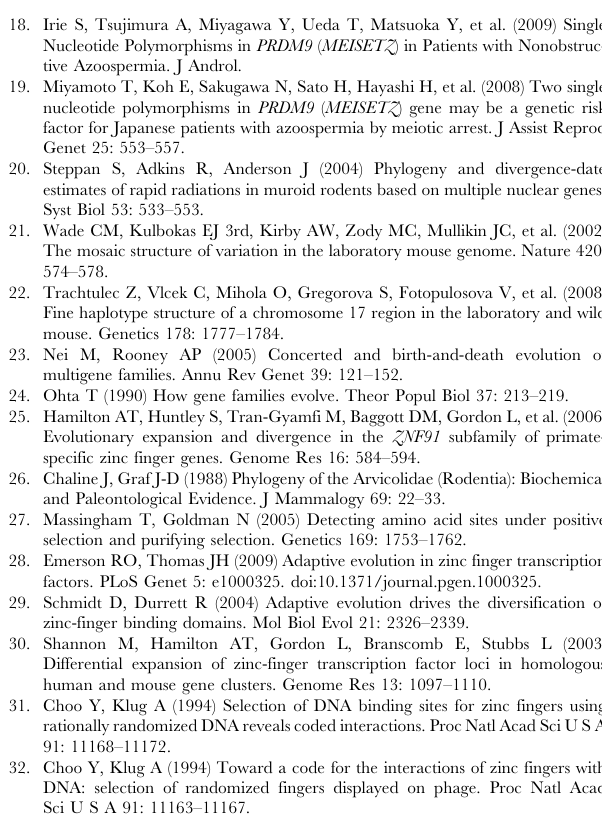
Figure S1 Phylogenetic tree of rodent Prdm9 zinc finger nucleotide sequences as inferred by phyml [76] version 3.0 (http://www.atgc-montpellier.fr/phyml/) and drawn using Fig- Tree (http://tree.bio.ed.ac.uk/software/figtree). Zinc fingers are numbered sequentially from the C-terminal array. The exceptions are zinc fingers from the mouse and rat, whose numbers start from the first Prdm9 zinc finger in exon 11. For species names see legend to Figure 6. Branches with Approximate Likelihood-Ratio Test values of over 0.75 are indicated with bold lines. Found at: doi:10.1371/journal.pgen.1000753.s001 (6.18 MB EPS) Figure S2 Multiple sequence alignment (shaded according to a 90% consensus) of Prdm9 zinc finger sequences from the water vole ( Arvicola terrestris ) and field vole ( Microtus agrestis ). Found at: doi:10.1371/journal.pgen.1000753.s002 (2.75 MB EPS) Figure S3 Multiple sequence alignment (shaded according to a 90% consensus) of Prdm9 zinc finger sequences from the sea anemone, Nematostella vectensis . These form part of a predicted gene (NEMVEDRAFT_v1g113856) that has been predicted from scaffold_120 of the N. vectensis v.1.0 genome assembly (Joint Genome Institute). Found at: doi:10.1371/journal.pgen.1000753.s003 (2.64 MB EPS) Figure S4 Multiple sequence alignment (shaded according to a 90% consensus) of 23 Lottia gigantea Prdm9 zinc finger sequences. These have been predicted from scaffold 11 (bases 1507994- 1510370) of the Lottia genome assembly (v1.0) produced by the Joint Genome Institute. This gene prediction is supported by an expressed sequence tag from L. gigantea male gonad (accession code FC692069).